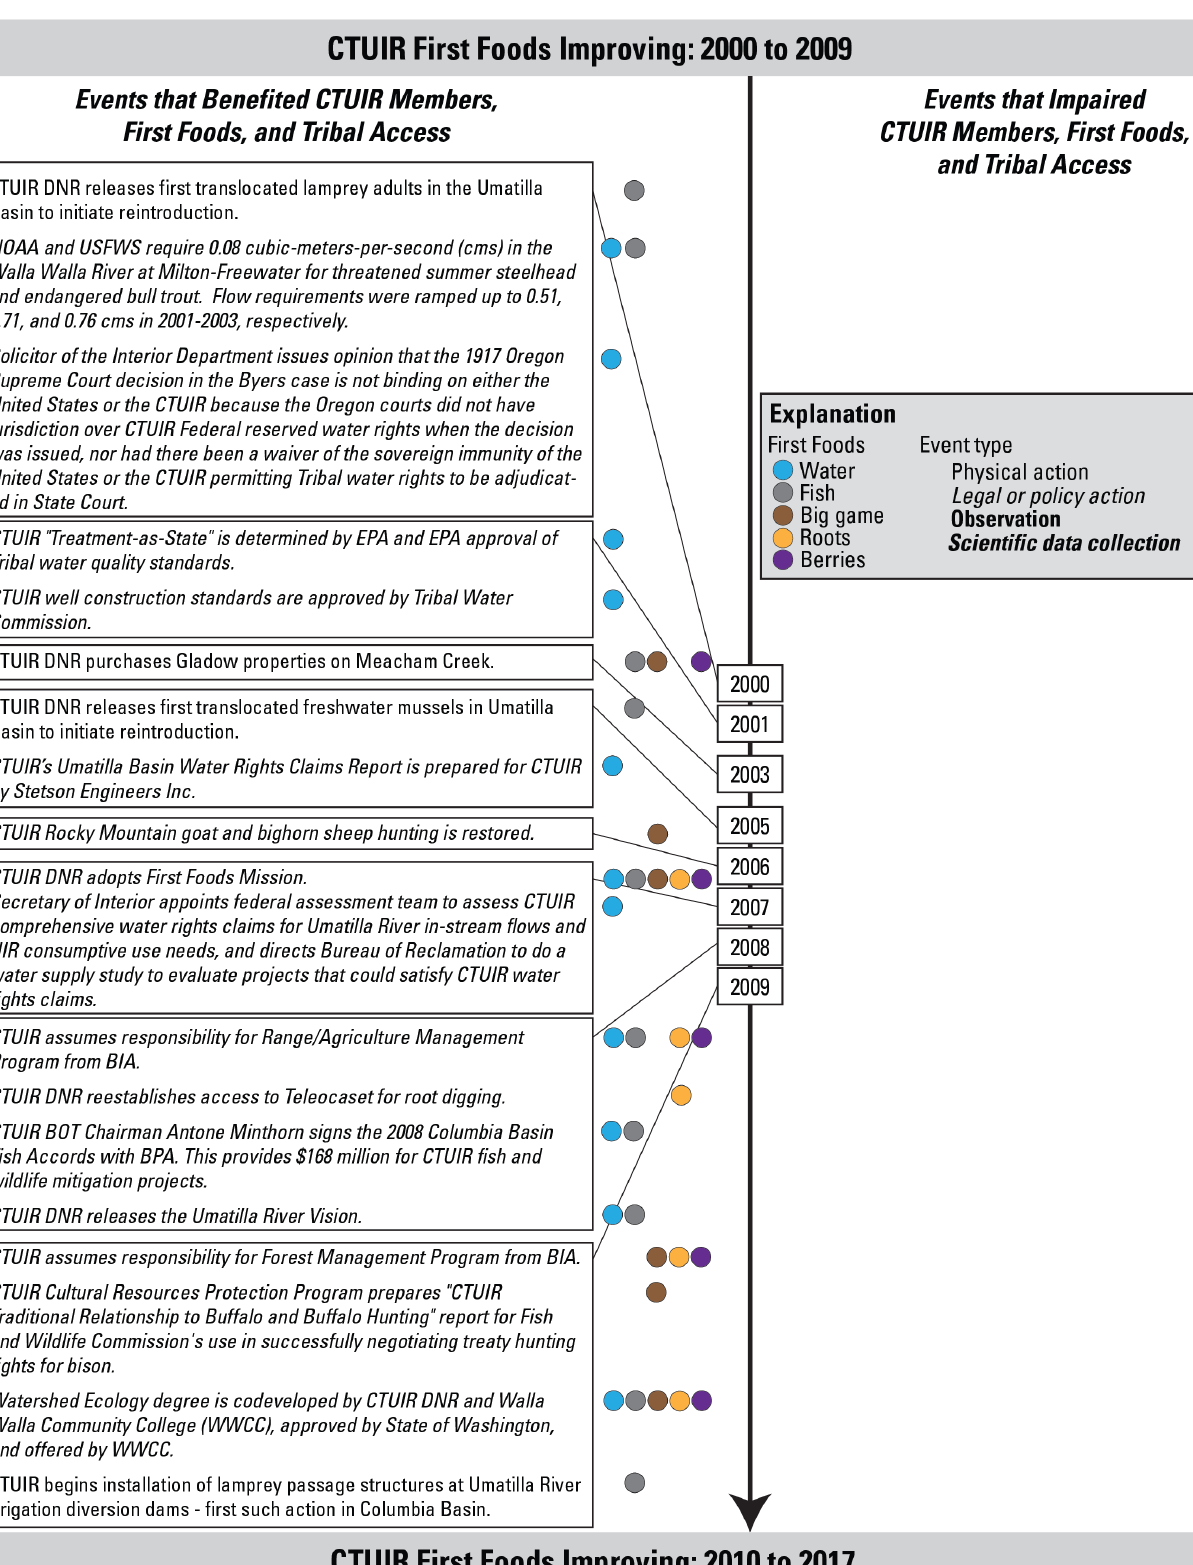
Fig. 8 . Timeline of representative events benefiting or diminishing First Foods and tribal access to them, 2000 to